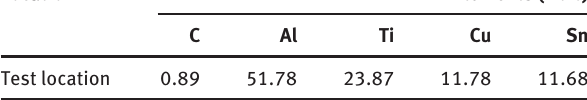
Table 2 EDS result of the location in laser alloying coating.